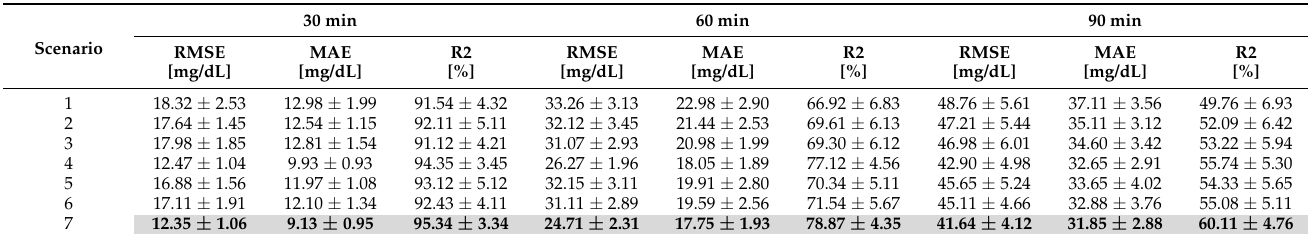
Table 2. Population results for LSTM model. RMSE [mg/dL], MAE [mg/dL] and R2 [%] for 30, 60 and 90 min ahead BG prediction, for different scenarios.